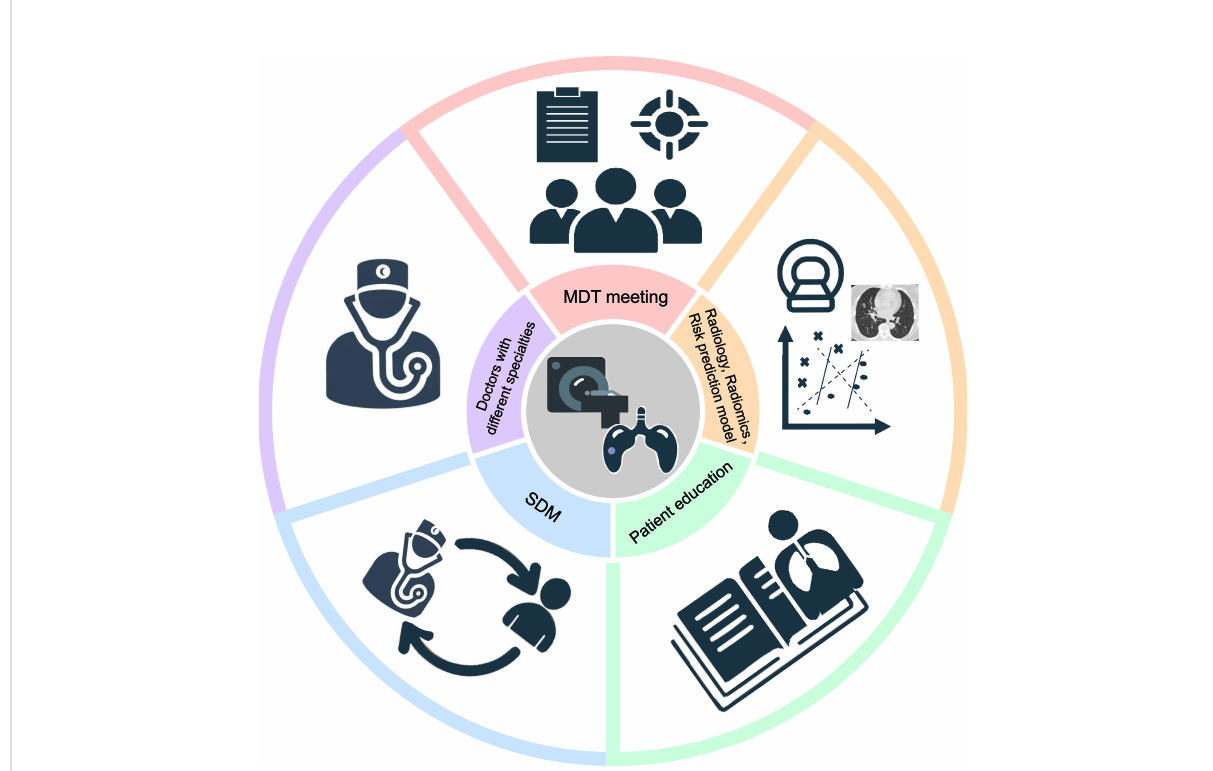
FIGURE 4 The vital factors in the individualized management of persistent SSNs. Five key factors are required for the individualized management of persistent SSNs, including doctors with different specialties, MDT(multidisciplinary team) meeting, radiology, radiomics, risk prediction model, SDM (share decision-making) and patient